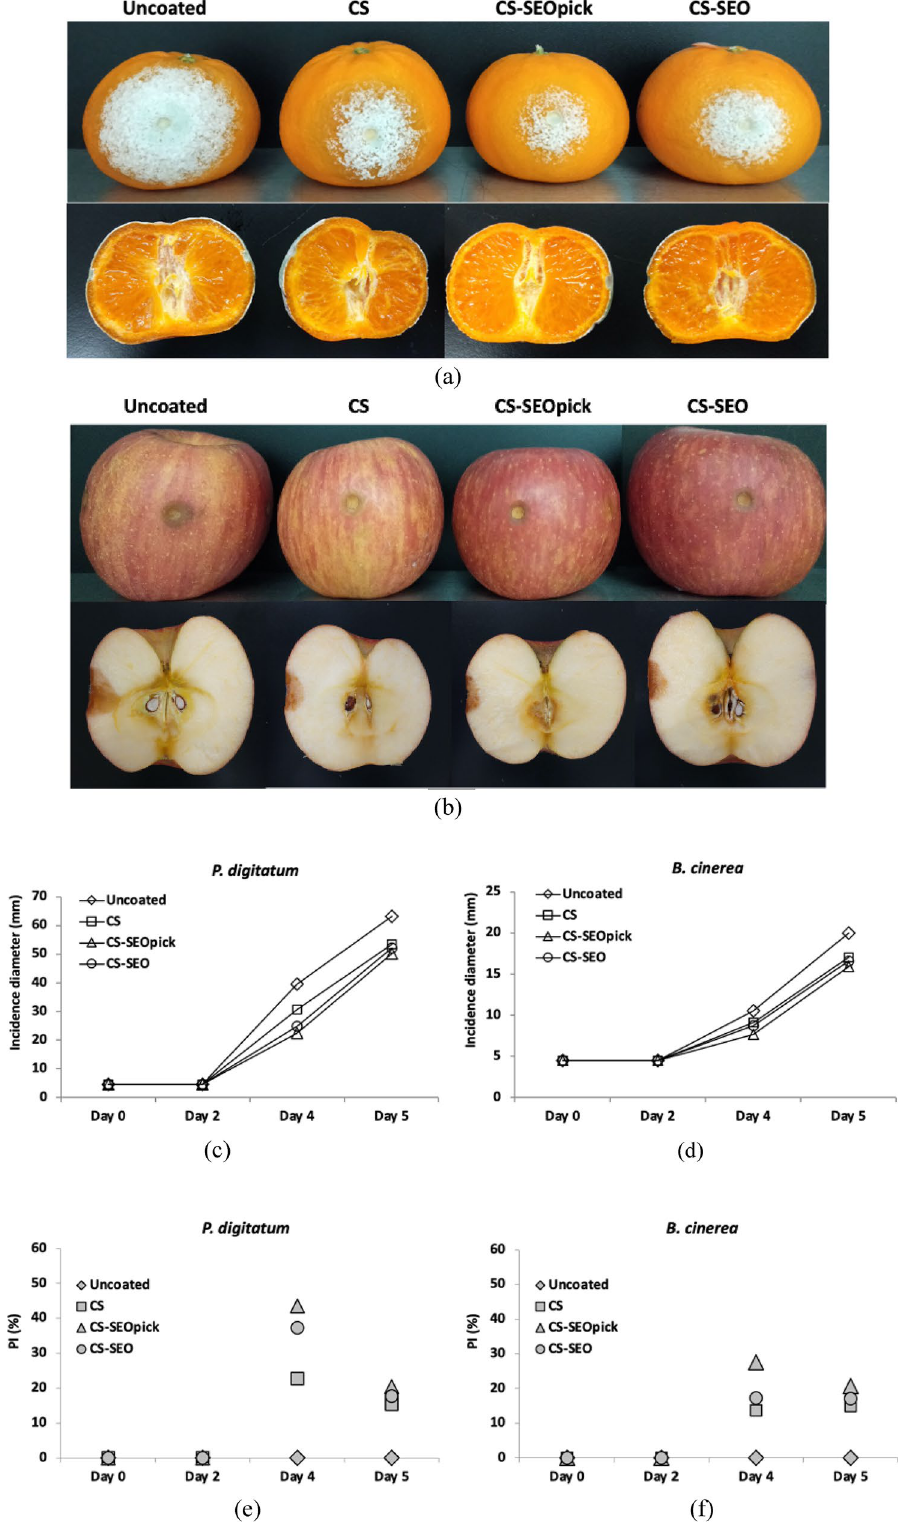
Figure 5. Efficacy of various coating treatment against P. digitatum and B. cinerea disease severity. ( a , b ) Visual appearance of representative sample and ( c , d ) statistical analysis during storage. PI percentage inhibition, CS chitosan, CS-SEOpick chitosan–sandalwood oil Pickering emulsion, CS-SEO chitosan–sandalwood oil regular emulsion coated